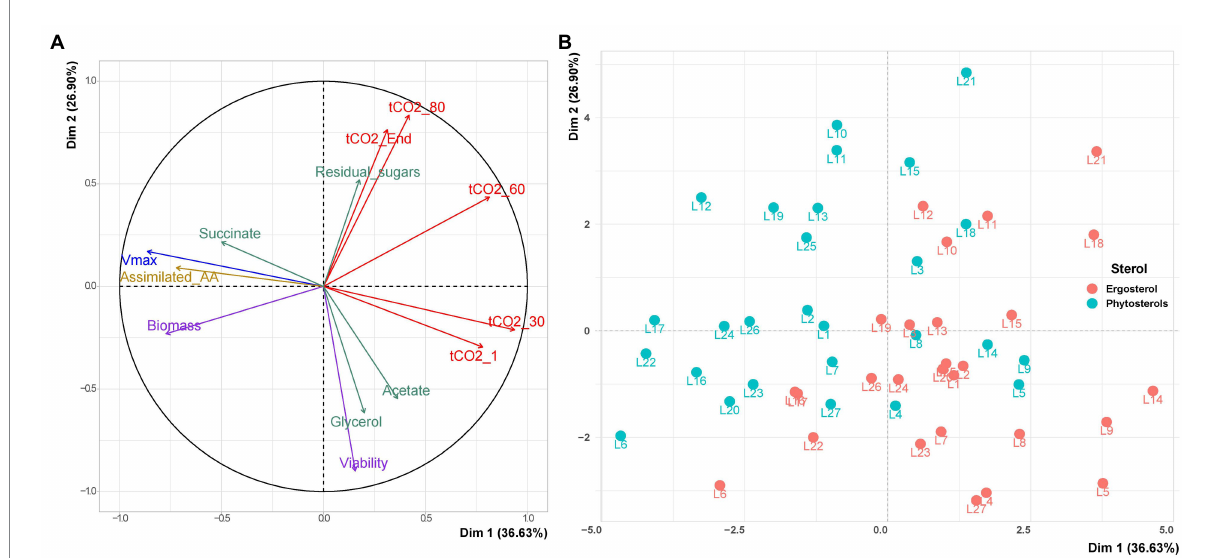
FIGURE 2 PCA for variables triplicate means of the 27 wine yeast strains under sterol limitation. (A) Projection of the variables used to describe fermentation kinetics, biological variables and central carbon metabolites on the 2 main components of PCA. The PCA variables are: maximum fermentation rate (Vmax), times to achieve 1, 30, 60, and 80 g/l of released CO 2 and the end of fermentation (tCO2_1, tCO2_30, tCO2_60, tCO2_80 and tCO2_ End, respectively); viability, biomass and assimilated amino acids at 85% of fermentation progress (Viability, Biomass and Assimilated_AA, respectively); acetate, glycerol, succinate and residual sugars at the end of fermentation. (B) Projection of the